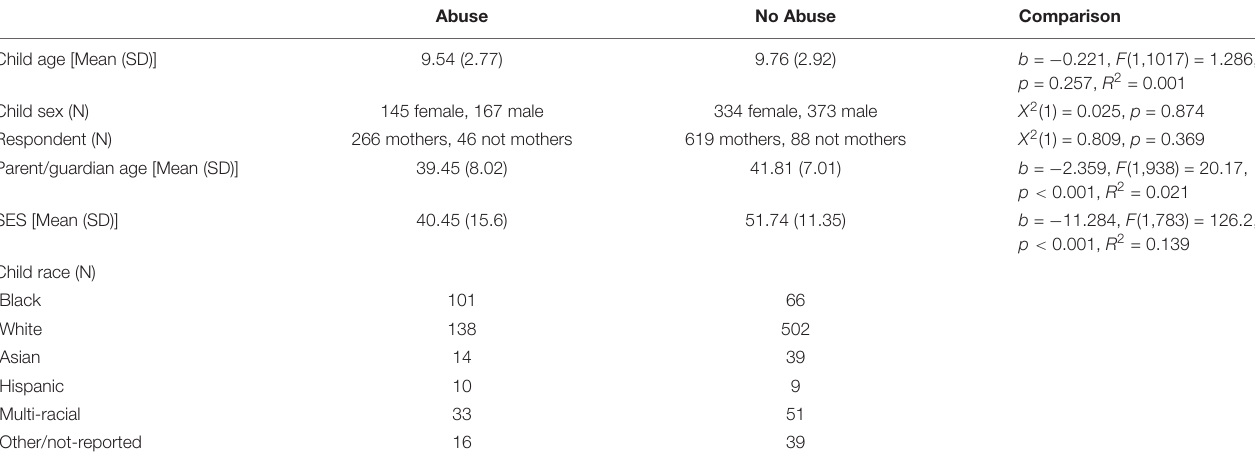
TABLE 1 | Participant and child demographics by group.